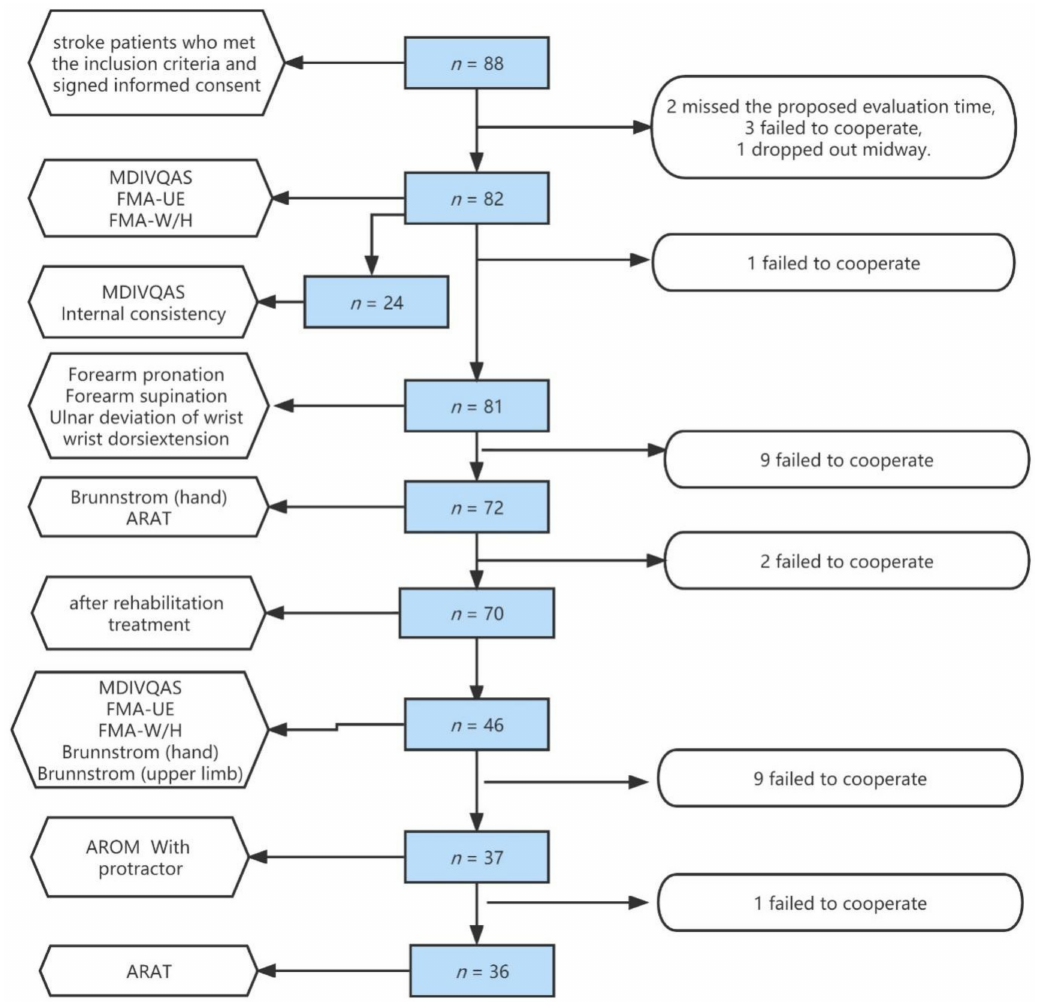
Figure 1. Flow chart of each stage in the